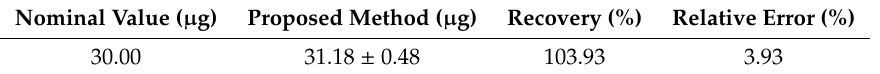
Table 10. Determination of Ethinyl estradiol in Pharmaceutical Product Using the Proposed